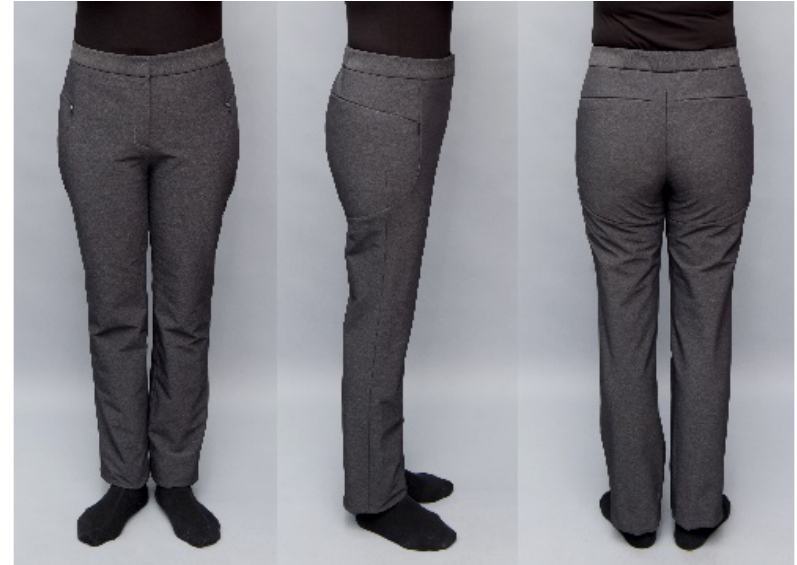
Figure 9. Appearance of the designed pants. Table 7. Results of appearance